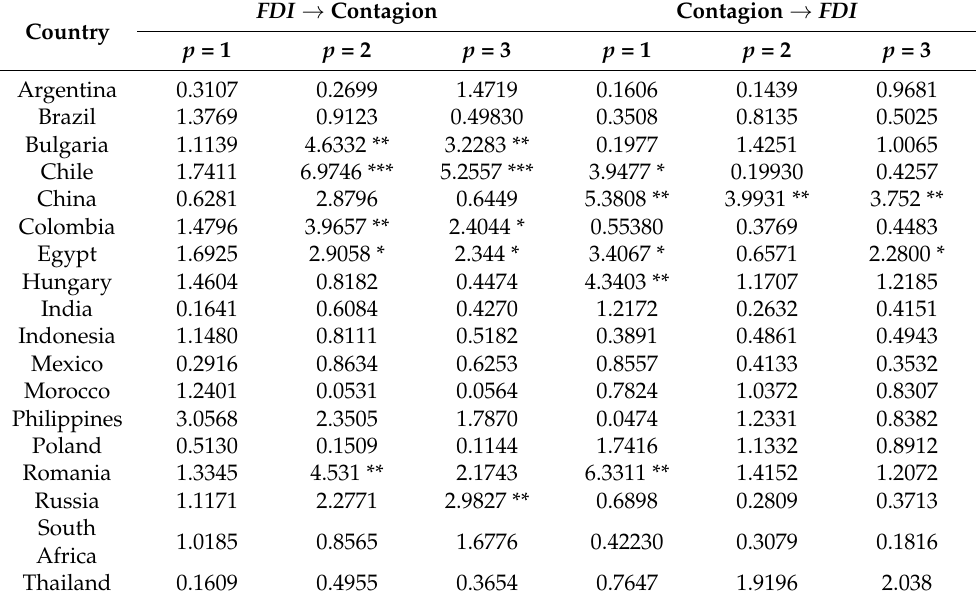
Table 8. Granger causality test for lags 1–3 (F-statistic